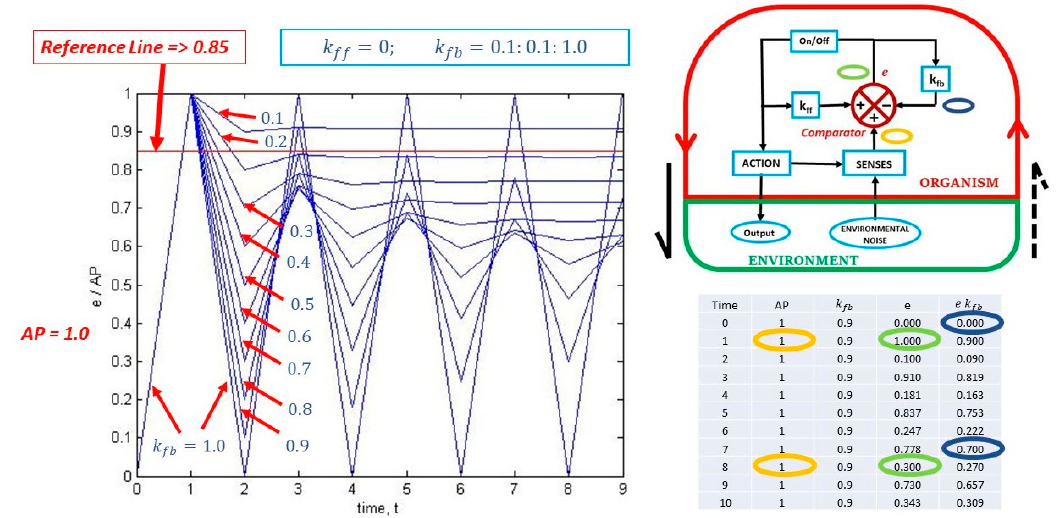
Figure 3. The effect of decreasing 𝑘 (cid:3033)(cid:3029) in the generation of richer dynamical behaviors. Figure 3. The e ff ect of decreasing k fb in the generation of richer dynamical